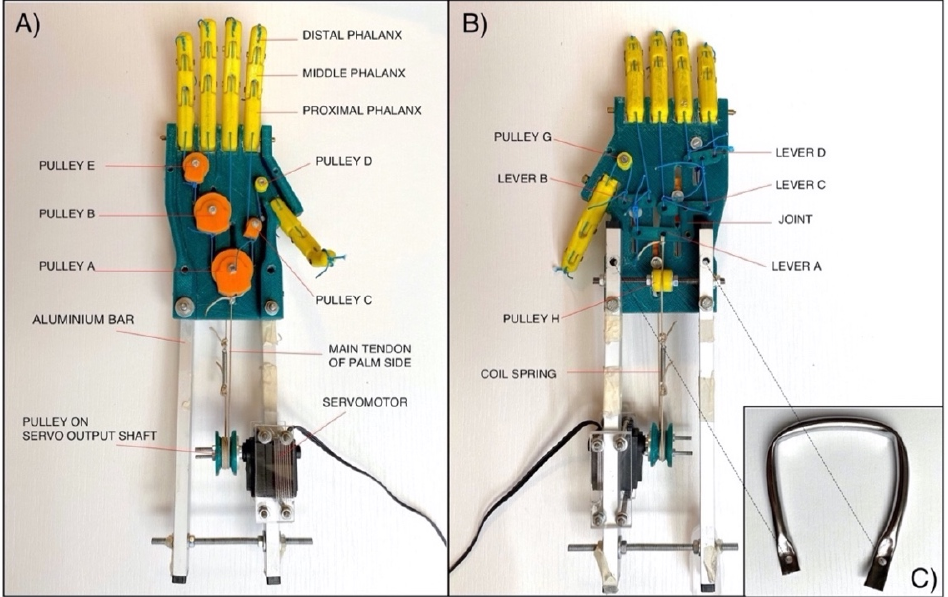
Figure 3. Current version of the “Federica” hand: ( A ) Palm view; ( B ) Back view; ( C ) Handle. Two aluminum bars were mounted on the back side of the prosthesis to remotely fix the servomotor.